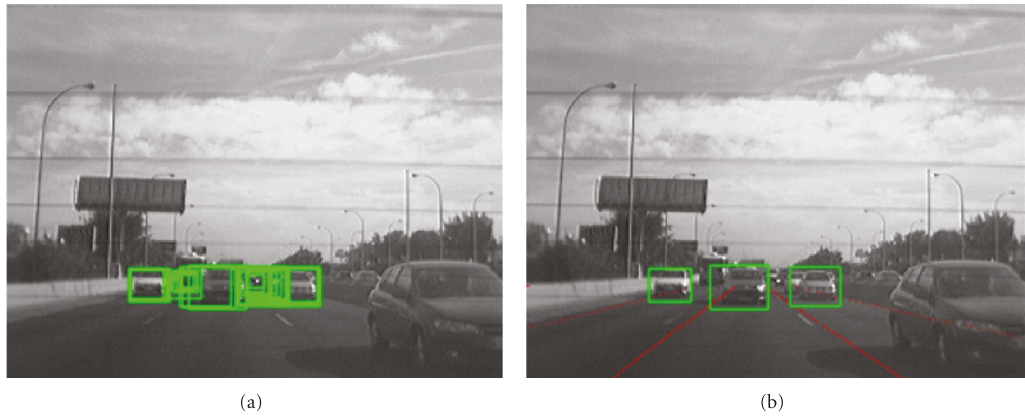
Figure 11: (a) Overlapped candidates. (b) Nonmaximum suppression